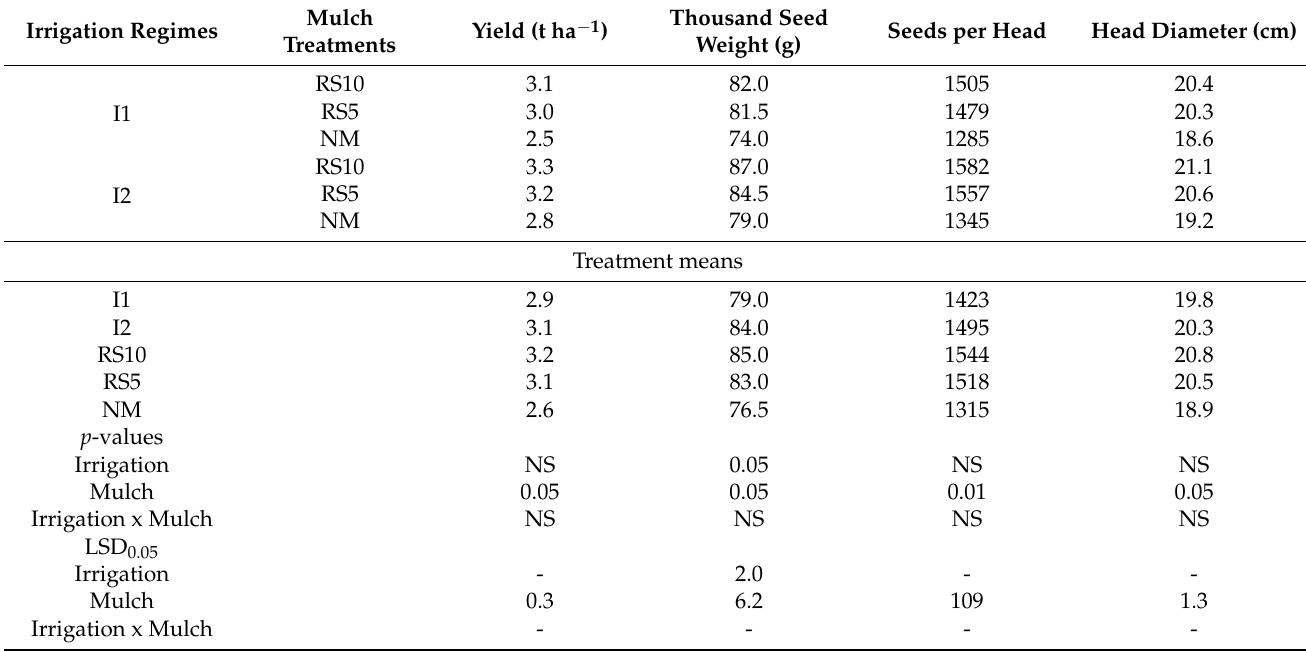
Table 2. Yield and yield attributes of sunflower under different mulch treatments and irrigation regimes in Pankhali, Dacope, Bangladesh in